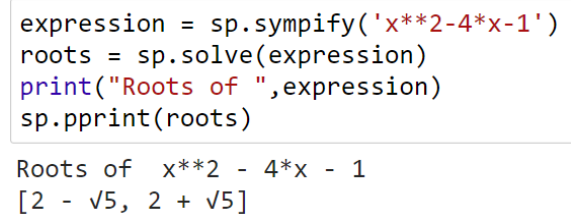
Figure 6. Polynomial manipulation.